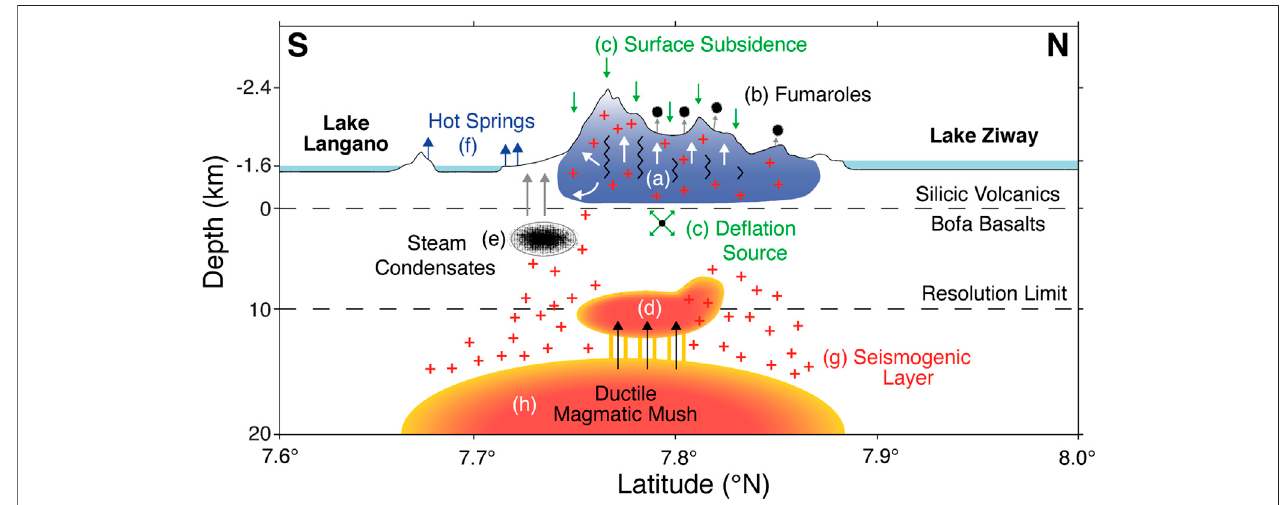
FIGURE7| SchematicdiagramoftheinterpretedsubsurfacestructureandprocessesatAluto,basedonthenewresultsandconstraintsfrompreviouslypublished studies. The key features are: (A) high seismicity within a low V P / V S region of over-pressurized gas at/close to a supercritical state, associated with (B) fumarolic activity andcausing (C) out fl owdrivensurfacede fl ation; (D) ahigh V P / V S regionwithasigni fi cantmeltcomponentthathasascendedfrombelow; (E) shallowhigh V P / V S regions of steam condensates that release volatiles to the surface via (F) hot springs; (G) a deeper seismogenic region, convex with latitude; (H) a ductile reservoir of magmatic mush.